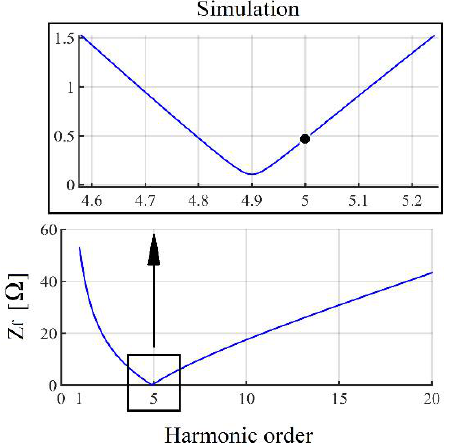
Figure 13. Filter impedance versus frequency characteristic (simulation).